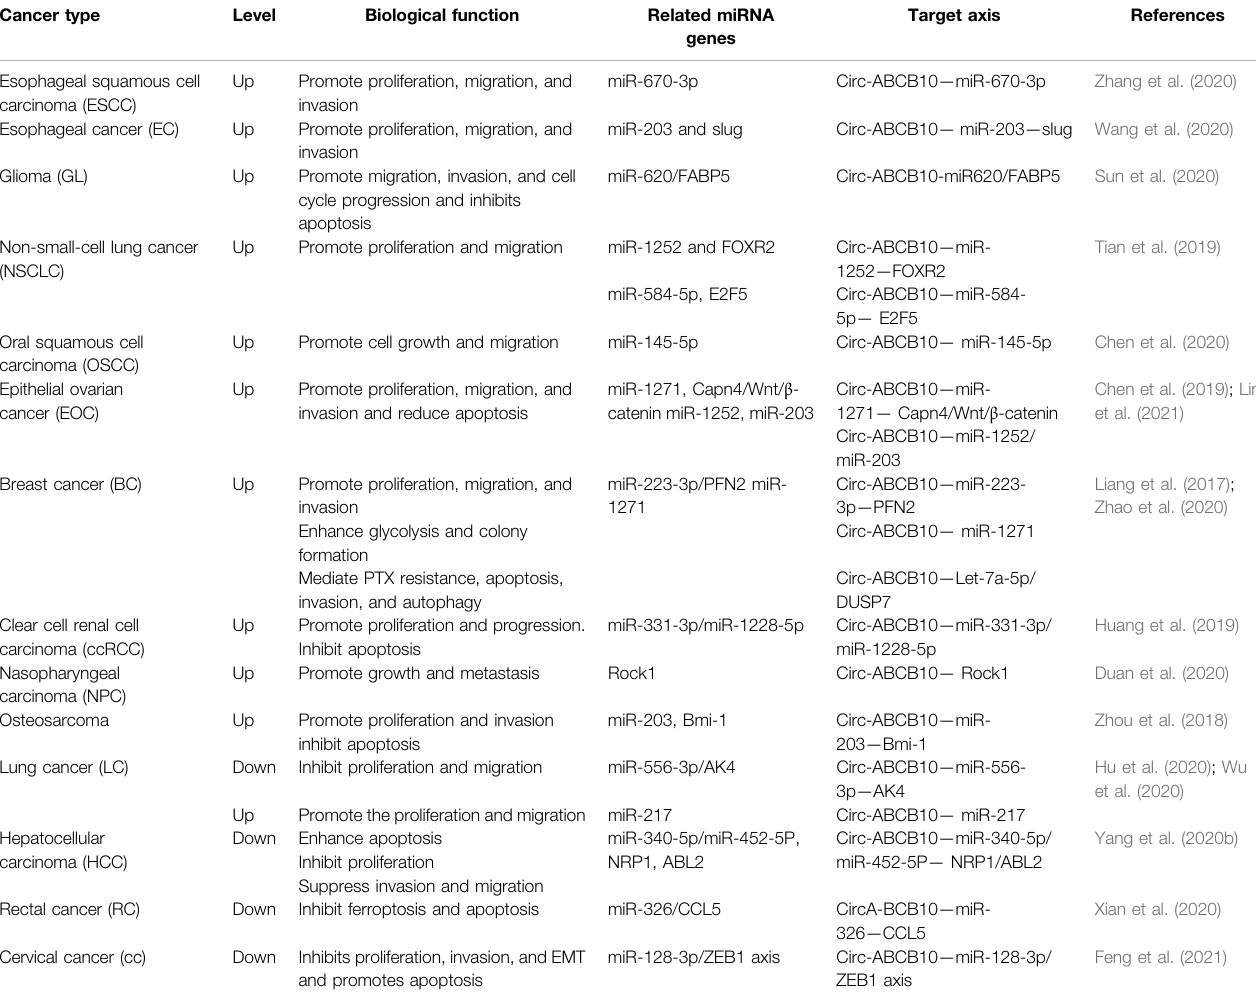
TABLE 1 | Expression and functions of circ-ABCB10 in different